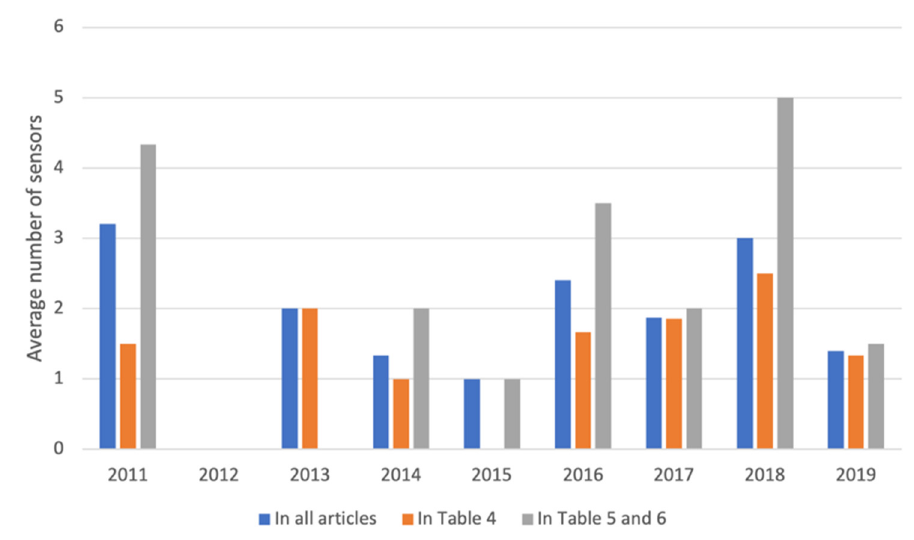
Figure 5. Average number of sensors per publication year for: (1) all articles, (2) the articles in Table 4, and (3) the articles in Tables 5 and 6. and (3) the articles in Tables 5 and